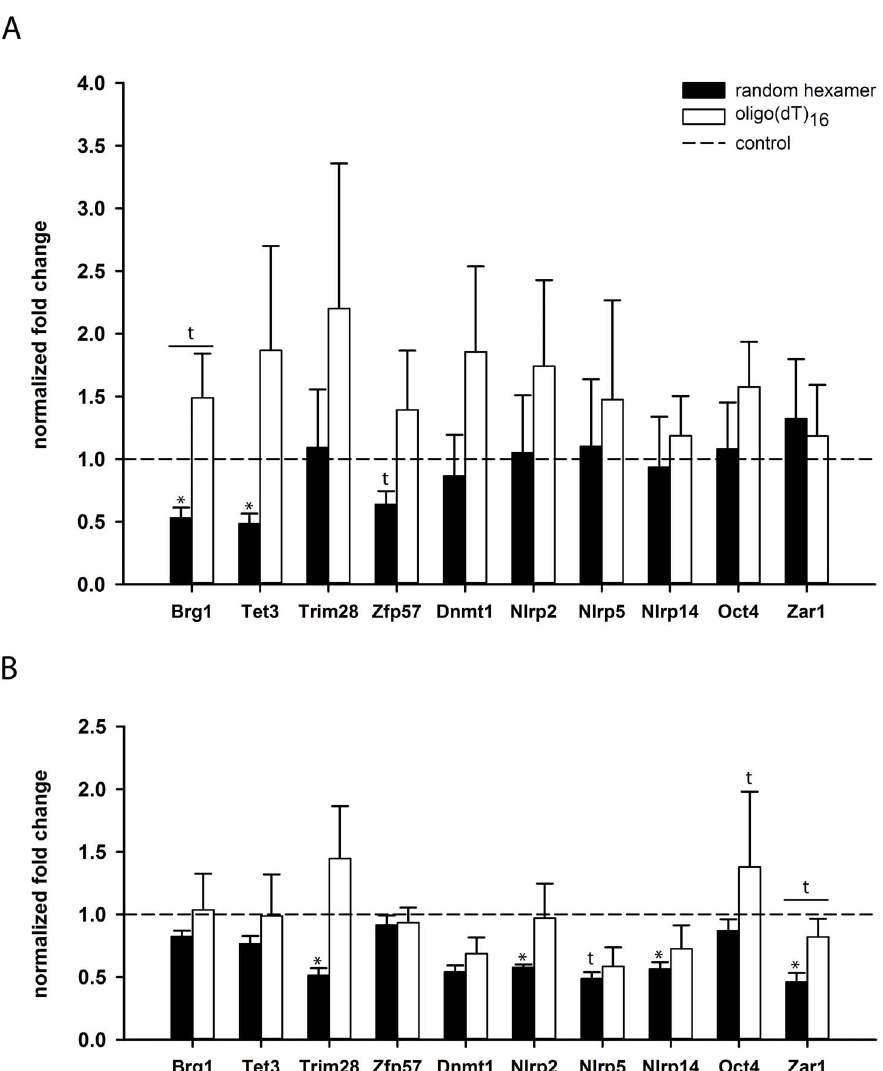
Figure 3. Expression levels and poly(A) content of ME genes in preovulatory-aged oocytes. The normalized fold change (mean 6 SEM) of preovulatory-aged oocytes compared to control oocytes (dotted line) of total transcript (black bars) and polyadenylated transcript (white bars) is shown. A) After preovulatory in vivo aging, oocytes show a significant decline in total transcript levels for Brg1 and Tet3 . Comparison of total with polyadenylated transcript levels reveals that poly(A) content of ME gene mRNA tends to increase during preovulatory in vivo aging. B) Total transcript amounts of Trim28 , Nlrp2 , Nlrp14 and Zar1 decreased significantly after preovulatory aging in vitro. A similar trend was observed for Nlrp5 . Several genes investigated showed a tendency towards a relative increase in poly(A) content compared to total transcript levels, which was most evident for Zar1 (t: P , 0.10, * P , 0.05).